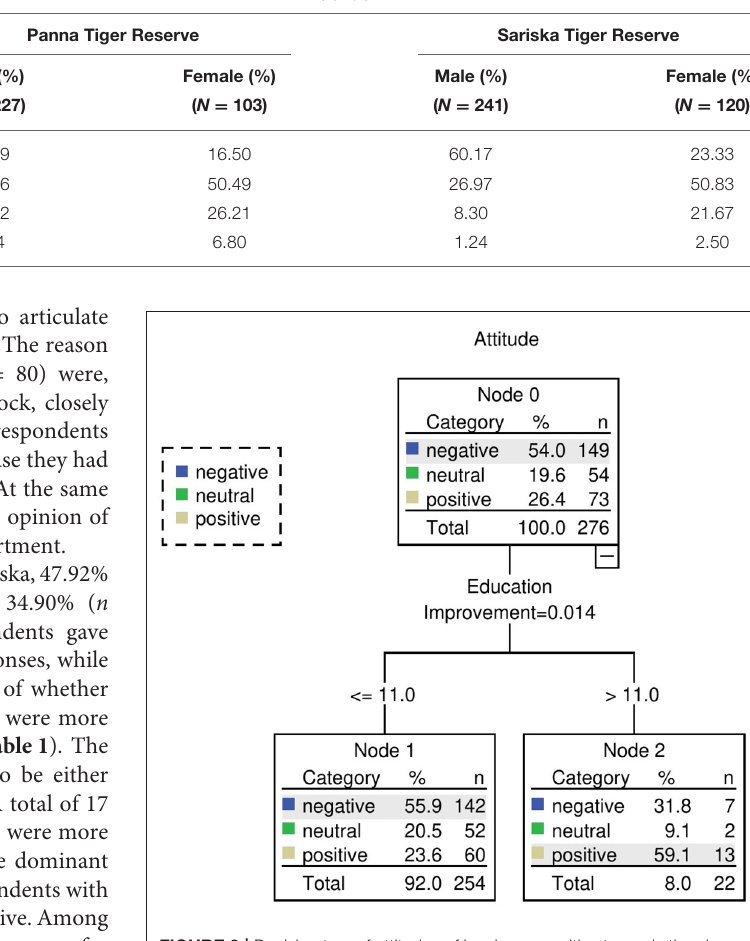
FIGURE 3 | Decision tree of attitudes of local communities towards tiger in Panna Tiger